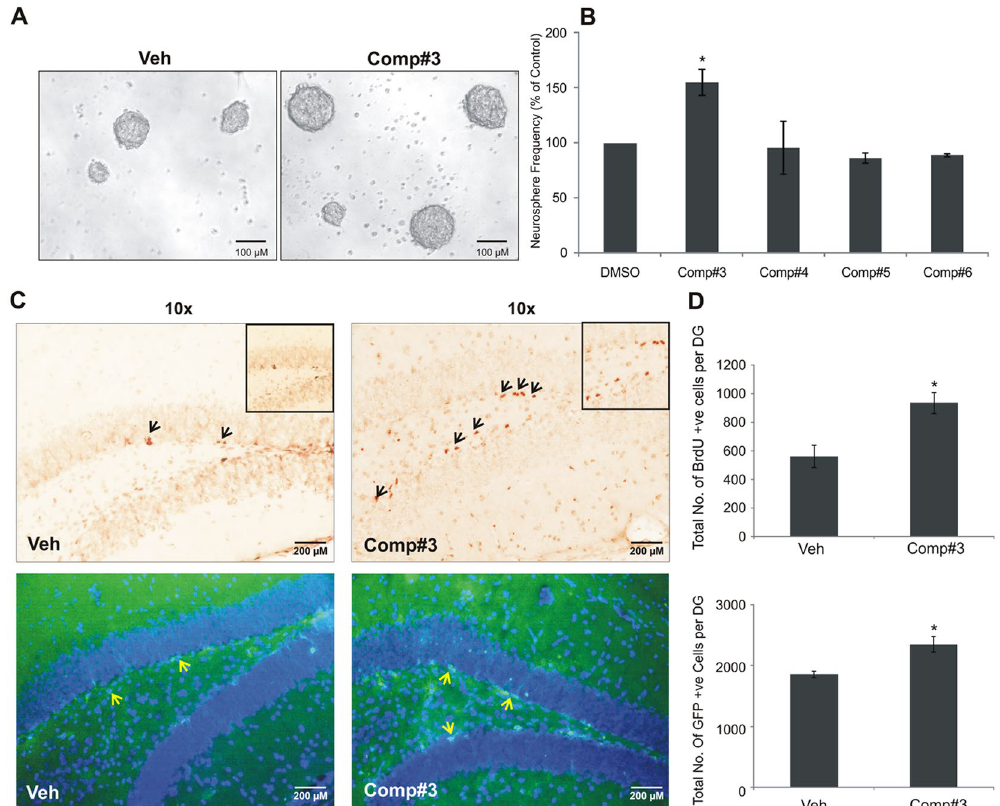
Figure 3. Neurosphere assay ( A,B ): Treatment of neural precursor cell population from postnatal (P2–3) mouse hippocampus by novel compounds in ex vivo assay shows the neurogenic potential only in #3; results are expressed as mean ± SEM, where neurosphere frequency ( > 100 μ m size) is represented as percentage of control (n = 3/group); * p < 0.05 compared with the control (student’s t-test). ( C,D ) Shown are representative photomicrographs of Nestin + ve cells (C, top panel) and BrdU + ve cells (C, bottom panel) from vehicle -(DMSO 1%) and compound treated groups. ( D ) Number of Nestin + ve and BrdU + ve cells in the SGZ at the border of the granule cell layer (n = 4–5/group), * p < 0.05 compared with vehicle (student’s